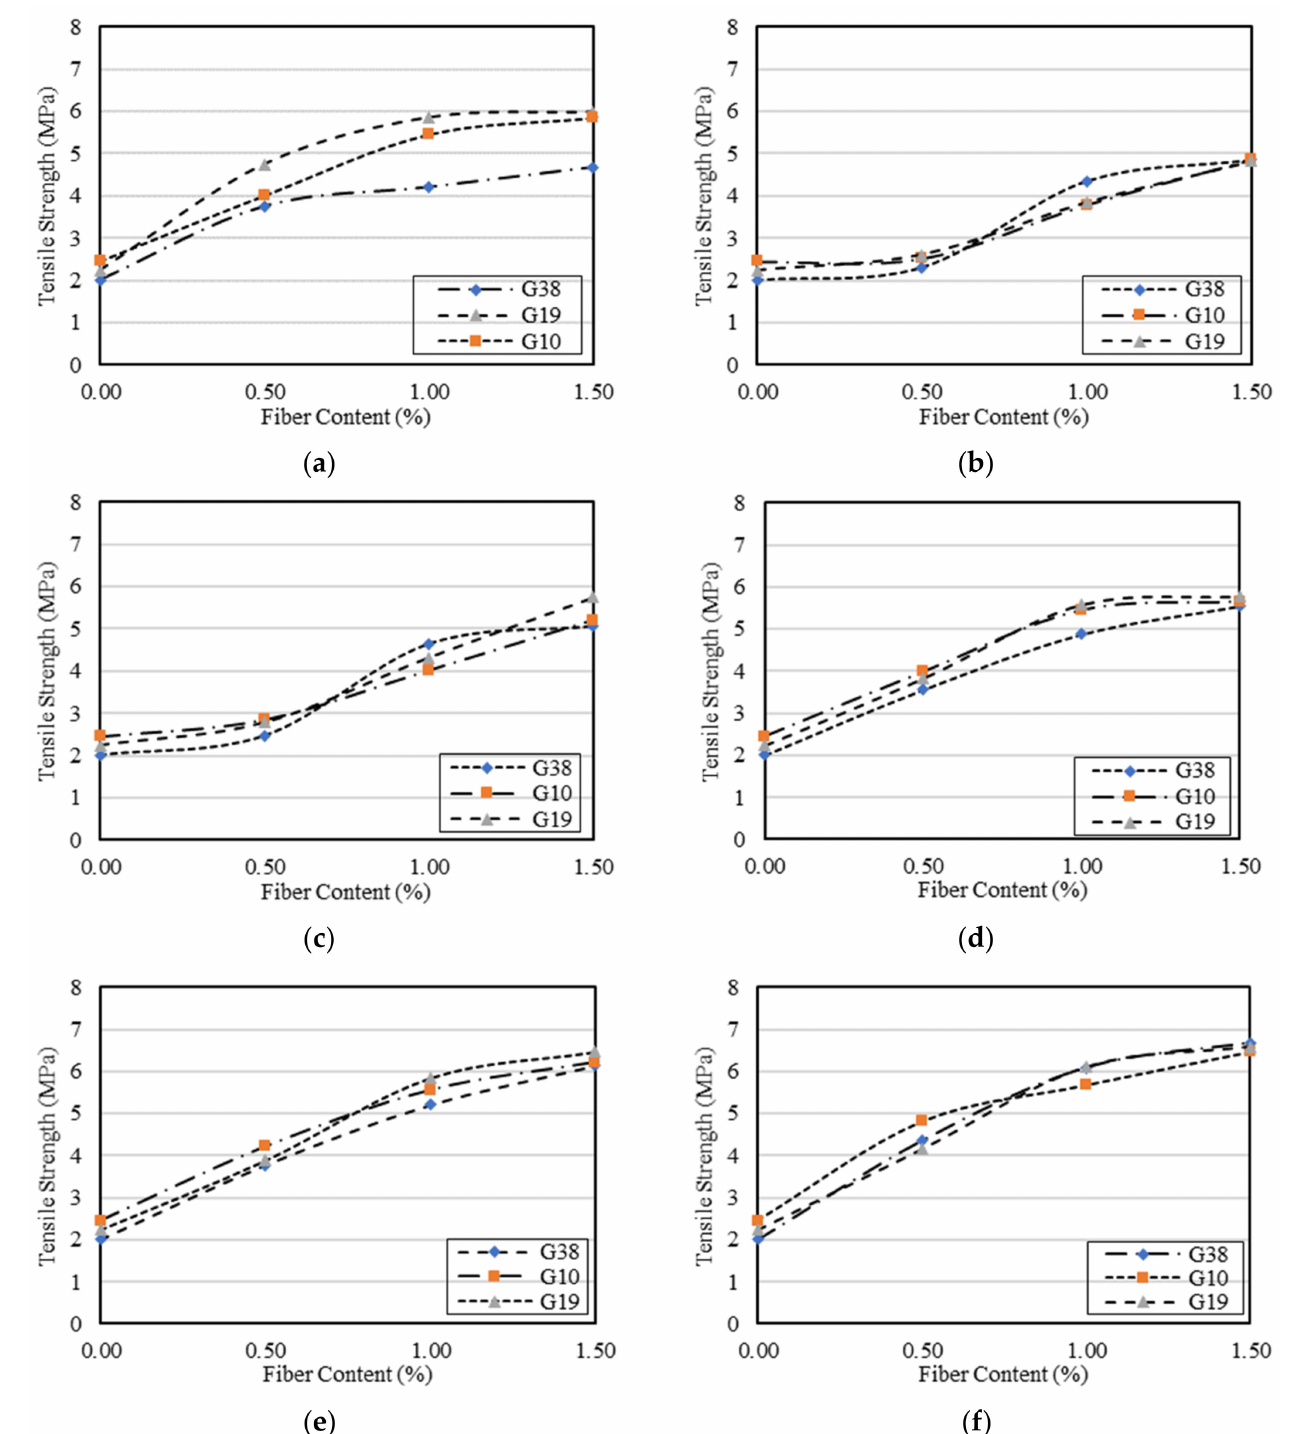
Figure 5. Effects of fiber type, dosage, and CAMZ on the tensile strength for the ( a ) MSF-13, ( b ) HSF-35, ( c ) HSF-60, ( d ) SYF-19, ( e ) SYF-38, and ( f ) SYF-54